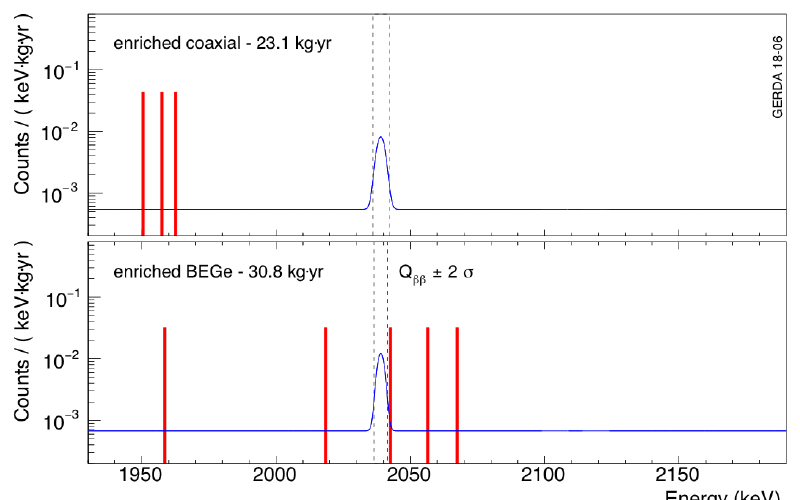
Figure 6. The G ERDA Phase II energy spectra zoomed at the ROI for the C OAX ( top ) and BEG E ( bottom ) data sets. Overlapped the maximal signal allowed from the maximum likelihood